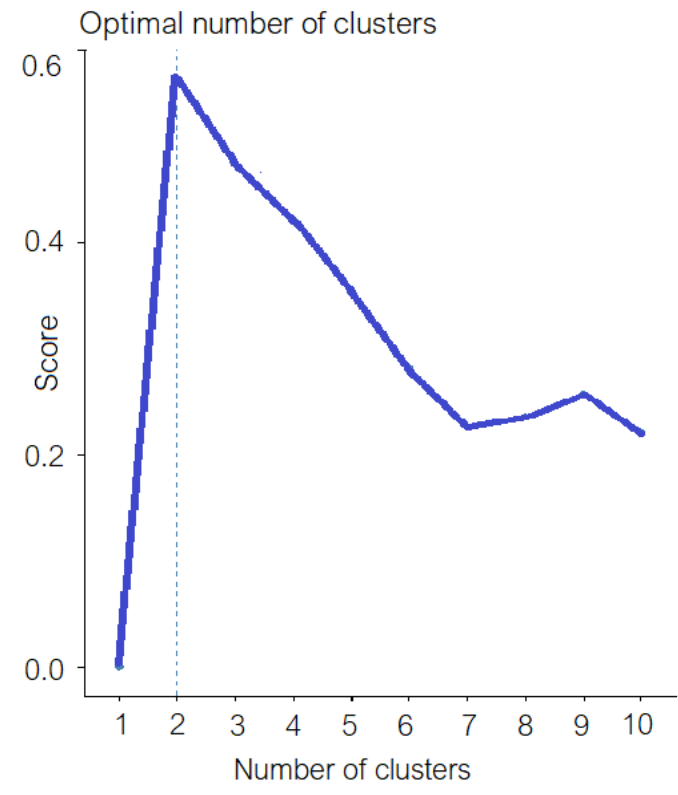
Figure 2. The silhouette chart. The dotted line indicates the optimum number of clusters (two). The dendrogram displaying the groups of the observation points is presented in Figure 3.